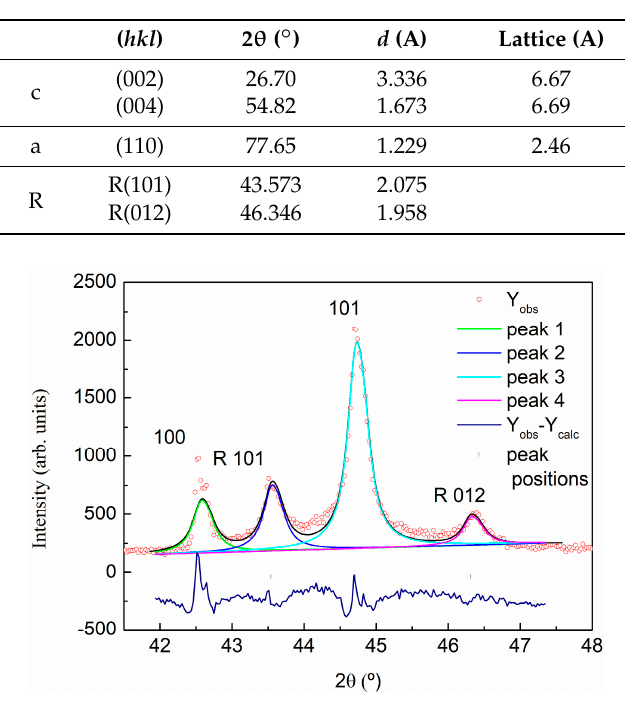
Figure 4. X-ray diffraction pattern of graphite. Profile refinement and the deconvolution of 41.5–47.5° 2 θ range of the pattern. Table 2. Measured interplanar spacings converted to lattice constants for graphite.